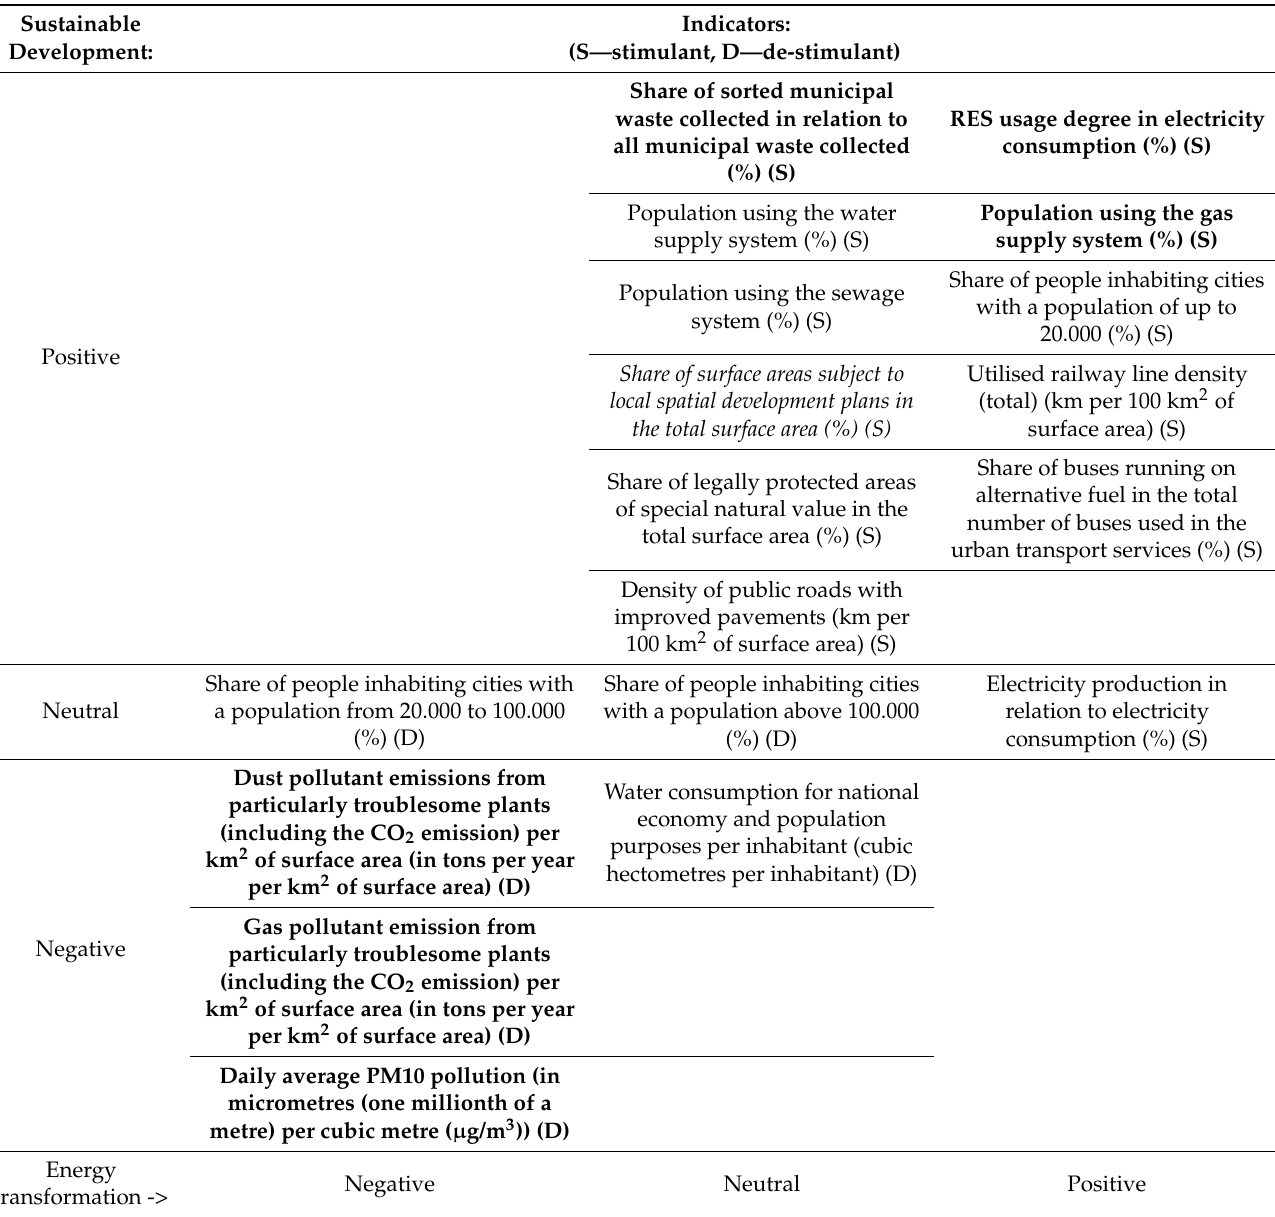
Table 1. Logical connection of indicators to energy transformation and sustainable regional develop- ment in the Opolskie